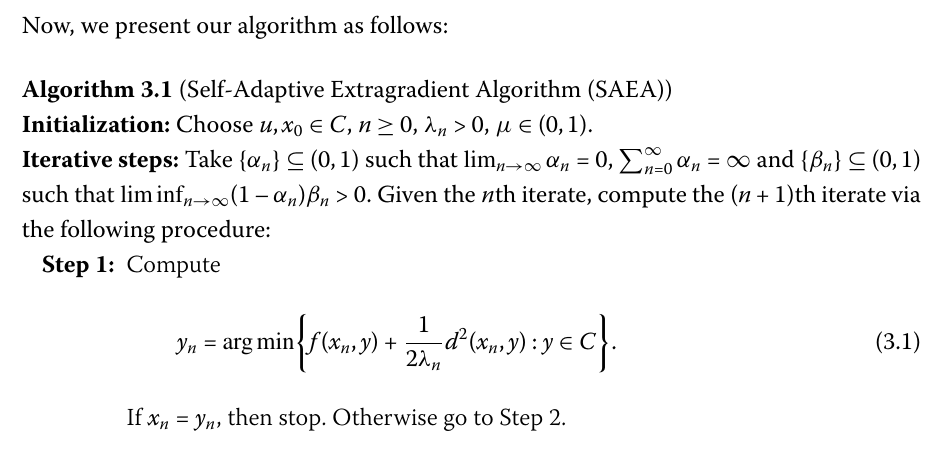
Algorithm 3.1 (Self-Adaptive Extragradient Algorithm